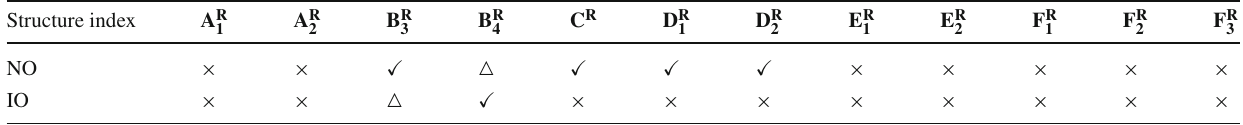
Table 5 The consistency between the neutrino oscillation parameters IO cannot be realized when we use the best fit value of θ 23 , but they are realized when we use the smallest value in the 3 σ region of θ 23 . and the mass ordering. “ (cid:4) ” represents the compatibility of the TZM structure with NO or IO when the best fit value of θ 23 is used, and “ × ” The subscript R means that the neutrino mass matrix has the two-zero minor structure does the opposite. “ (cid:14) ” in the B R and B R cases mean that the NO or 3 4 Structure